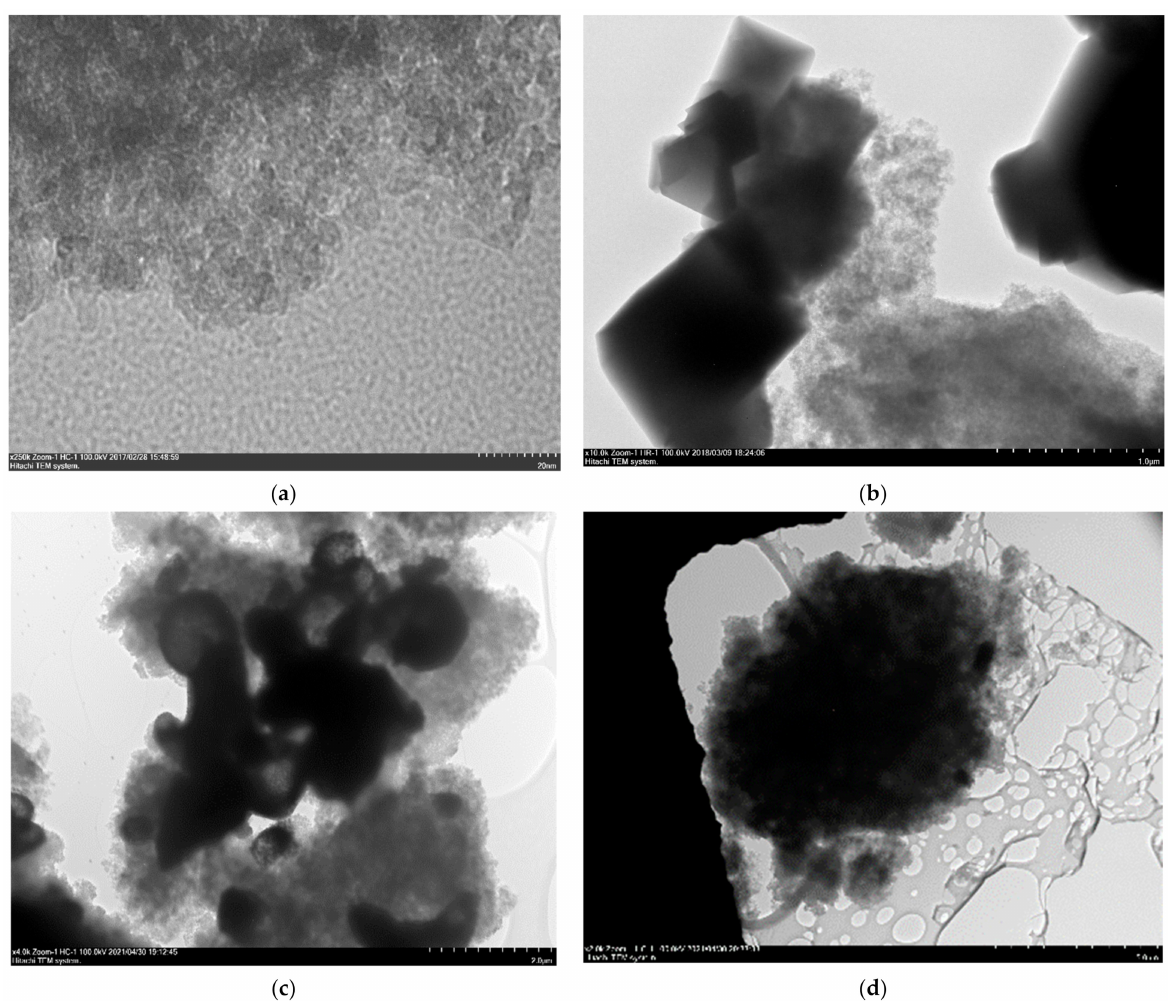
Figure 2. TEM micrographs of the bare BPS silica ( a ) and the HKUST-1@BPS composite samples 1 ( b ), 2 ( c ), and 3 ( d ). The dimensions of the scale bars on TEM images are equal to 20 nm ( a ), 1 µ m ( b ), 2 µ m ( c ), and 5 µ m ( d